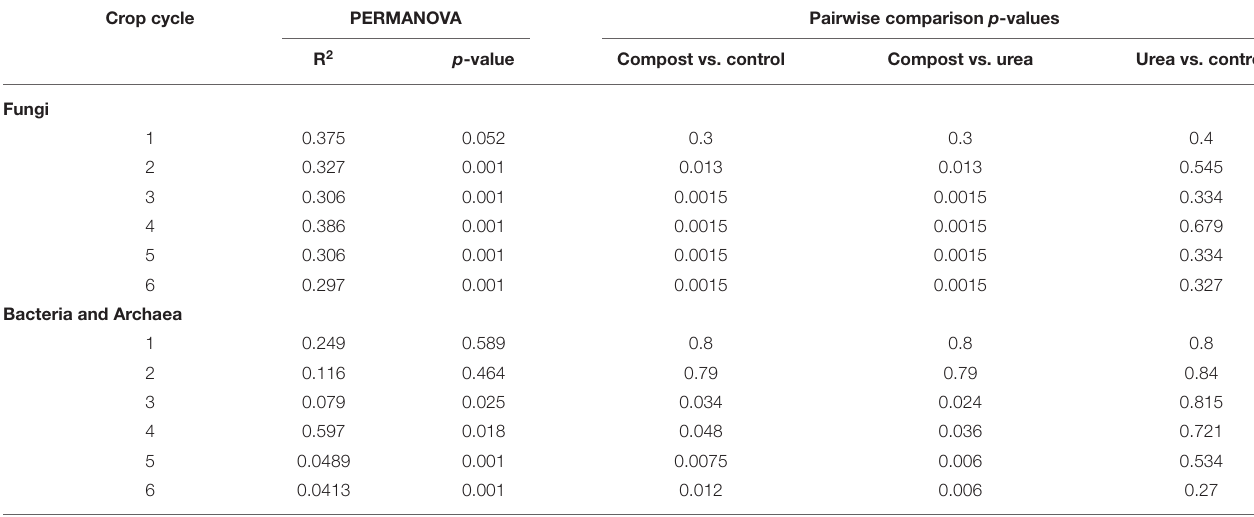
TABLE 3 | PERMANOVA and pairwise comparisons of community changes across treatments. Crop cycle PERMANOVA Pairwise comparison p -values R 2 p -value Compost vs. control Compost vs. urea Urea vs.